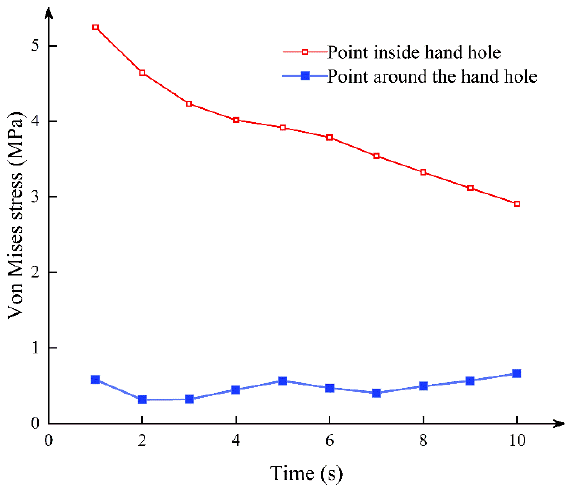
Figure 7. Stress–time curve of internal nodes and surrounding nodes of the hand hole.